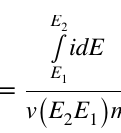
Table 1 Summary of EIS equivalent circuit parameters for ppy blank, ppy 100W-1 and ppy 100W-2 electrodes Parameters